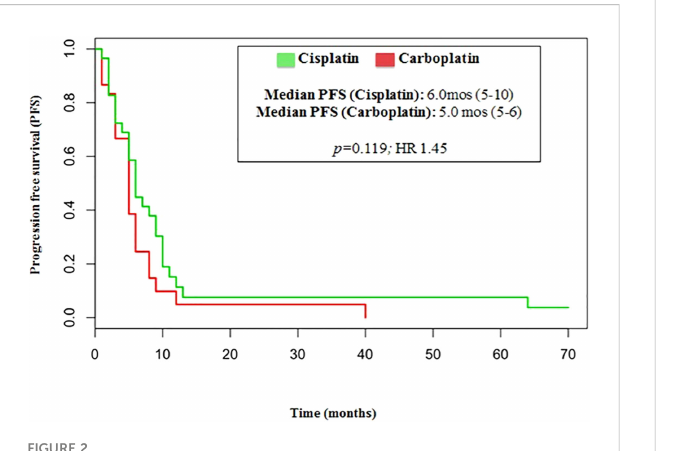
FIGURE 2 Median PFS related to cisplatin/etoposide scheme and carboplatin/ etoposide scheme.